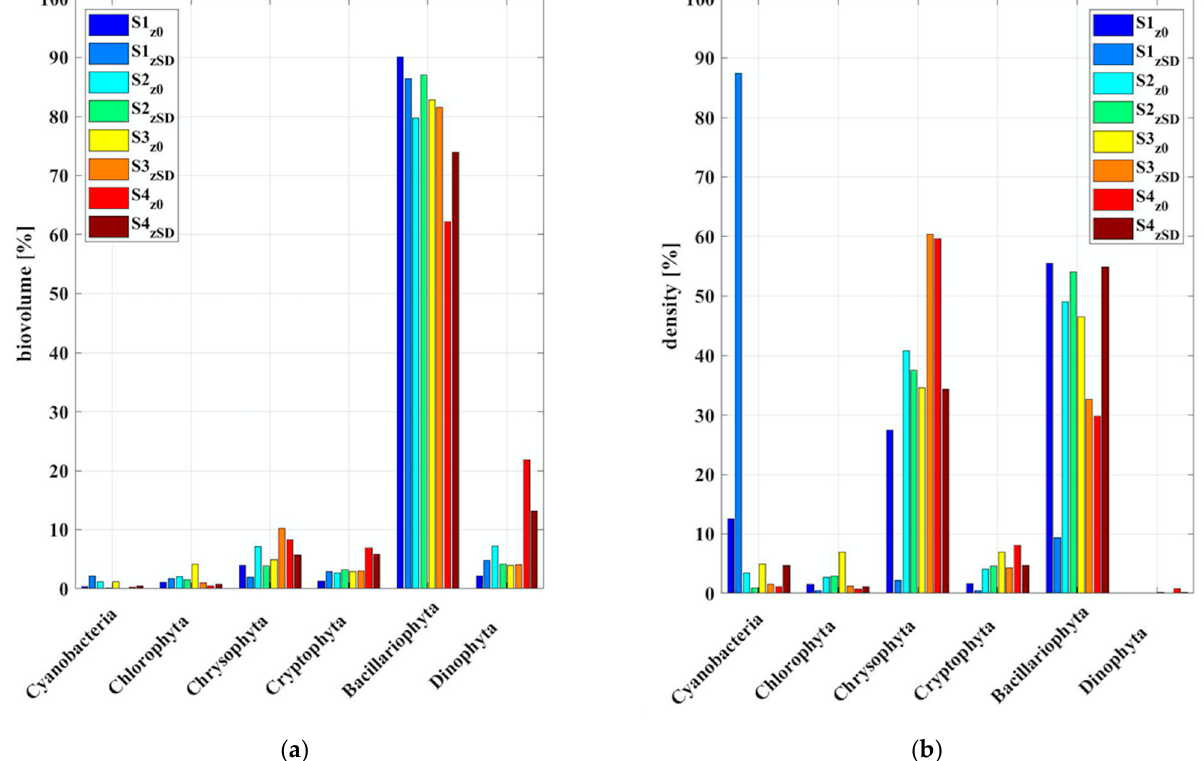
Figure 3. Composition of the phytoplankton major taxa expressed in percentages respect to biovolume ( a ) and density ( b ) in the water samples collected during the two-day water sampling. Colors indicate different samples depth and sampling dates.